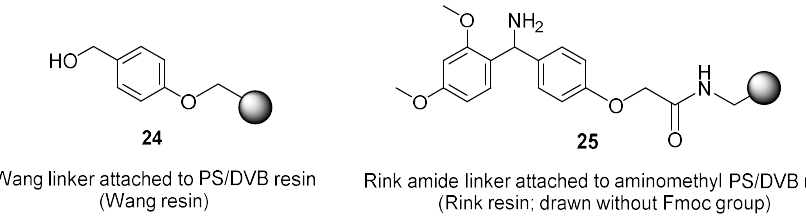
Figure 1. Solid-phase supports most frequently used in the review.